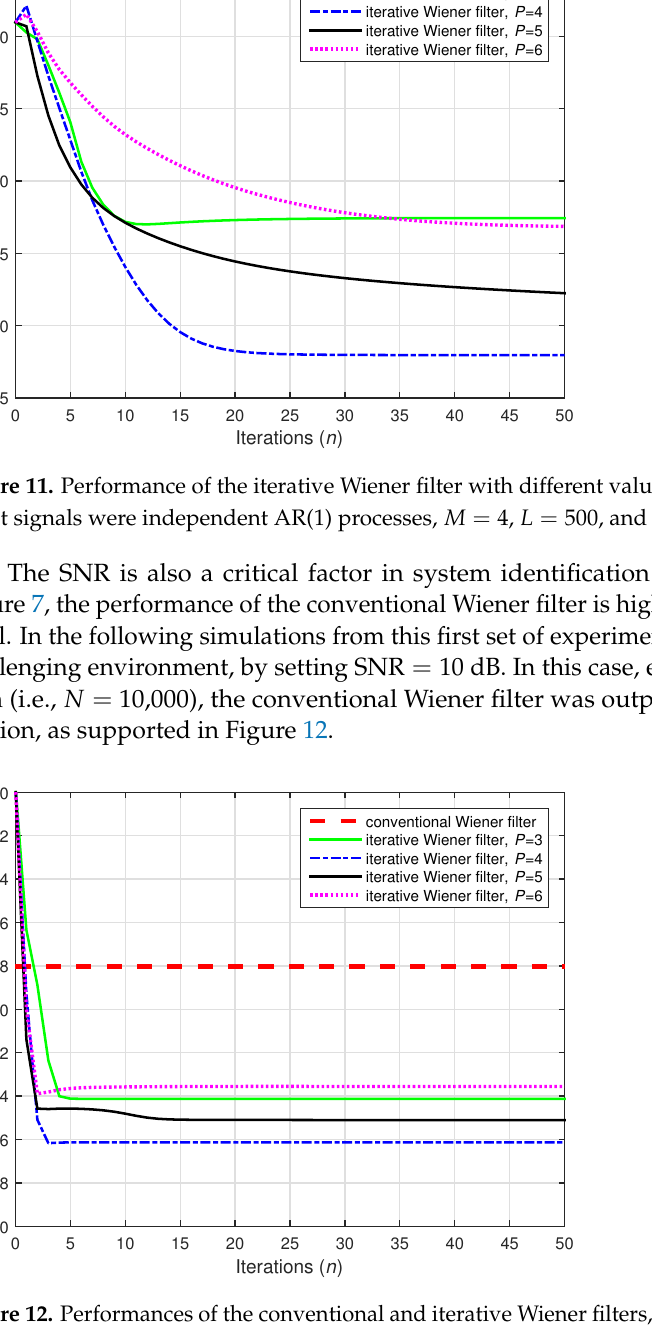
Figure 12. Performances of the conventional and iterative Wiener filters, using N = 10,000. The input signals were independent AR(1) processes, M = 4, L = 500, and SNR = 10